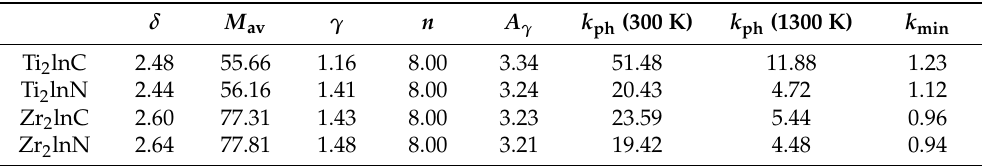
Table 8. Calculated δ (in Å), M av (in kg/mol), Grüneisen parameter γ , A γ ( × 10 − 8 ), and lattice